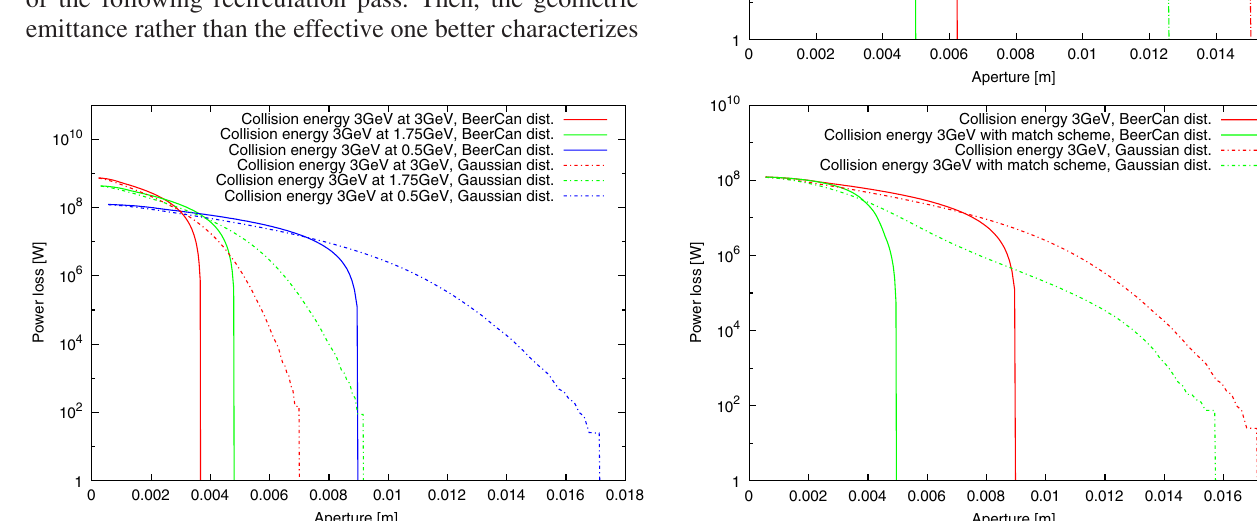
FIG. 18. (Color) Power loss at 0.5 GeV with or without match- ing scheme; in the top graph the collision energy is 10 GeV and in the bottom graph it is 3